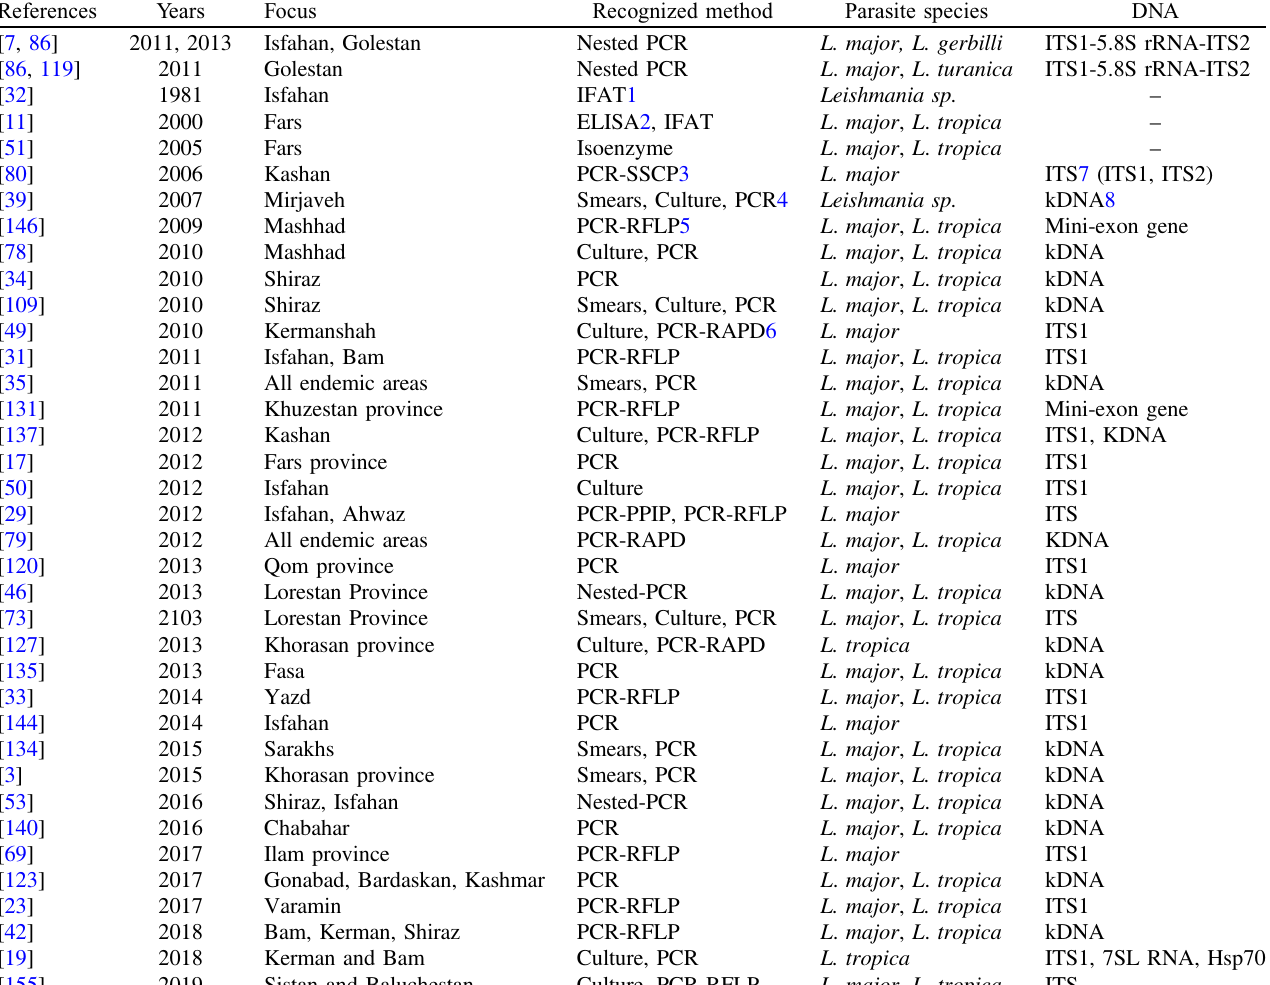
Table 3. Different Leishmania identi fi cation methods in human cases carried out in